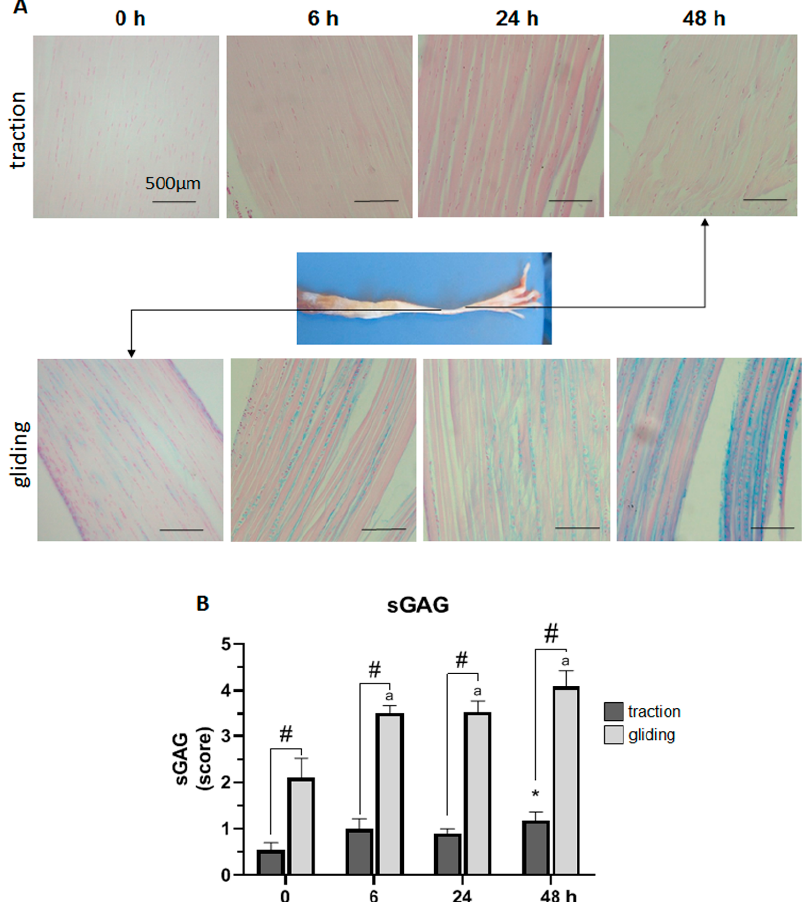
Figure 2. Impact of uniaxial force on sulfated glycosaminoglycan (sGAG) expression in traction and gliding areas of tendon. The images ( A ) show representative sections of the traction (upper